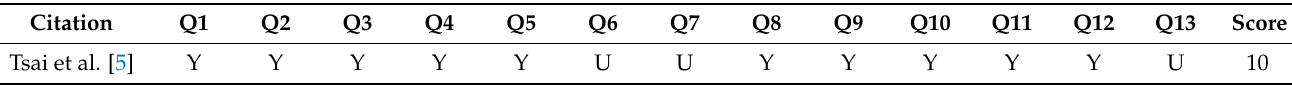
Table A2. Appraisal result of study quality for the RCT using the JBI-MAStARI (see Method Sec- tion 2.4 for questions